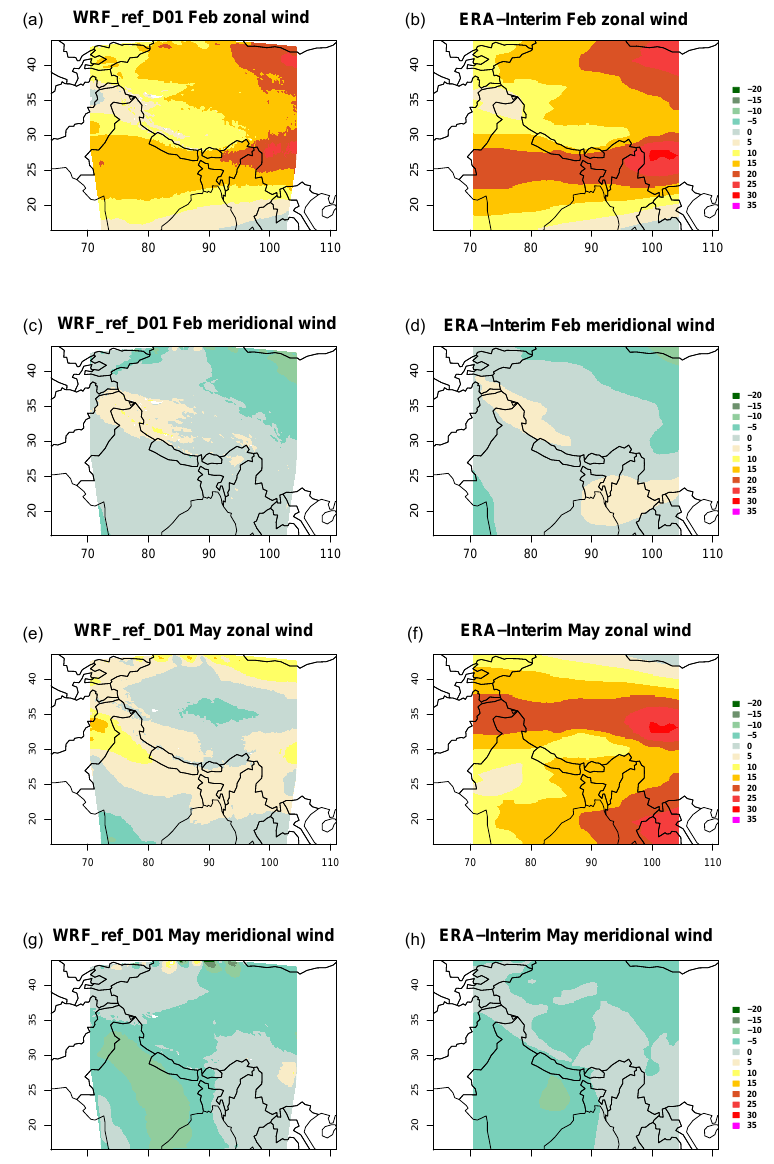
Figure 2. Zonal and meridional wind fields in 500hPa averaged over February and May 2013 for the WRF_ref_D01 simulation (a, c, e, g) and from the ERA-Interim reanalysis (b, d, f, h) in ms − 1 .